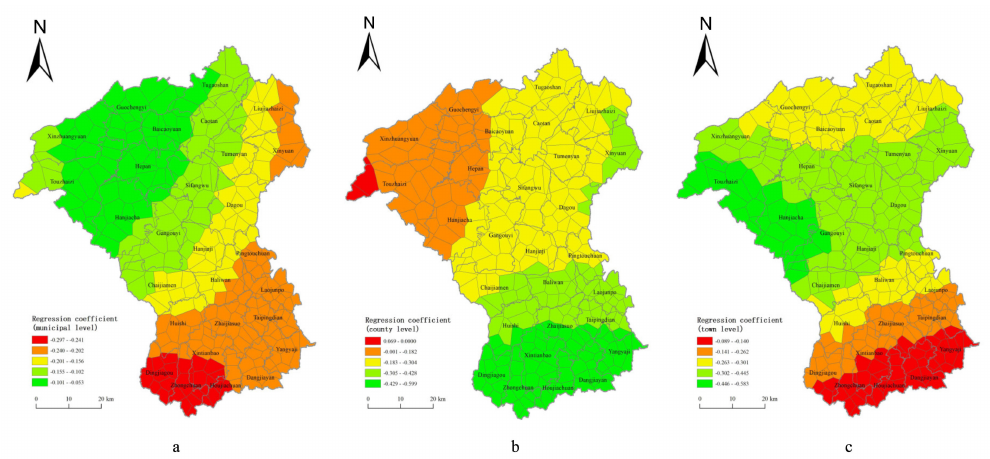
Figure 4. The GWR coe ffi cients between rural poverty and socioeconomic accessibility in the GWR model: ( a ) municipal-level accessibility, ( b ) county-level accessibility, and ( c ) town-level